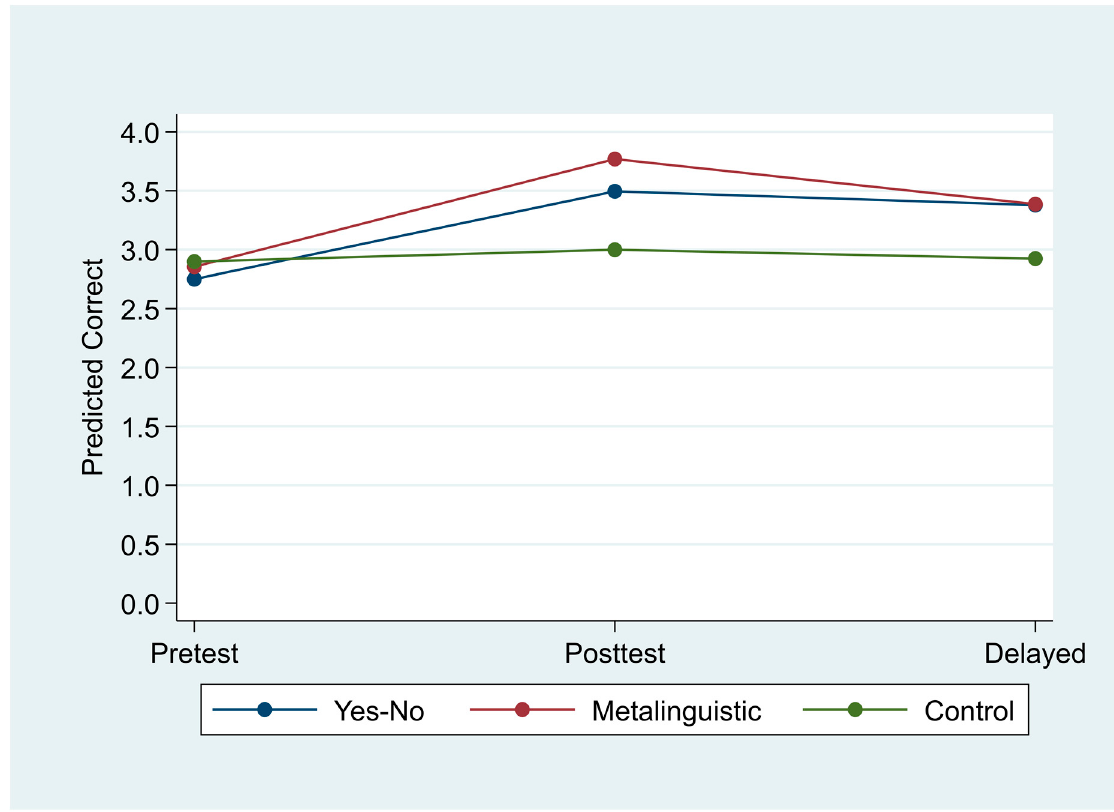
Figure 8. Predicted Probability of Accurate Interpretation in the Subject-Future Condition by Group and